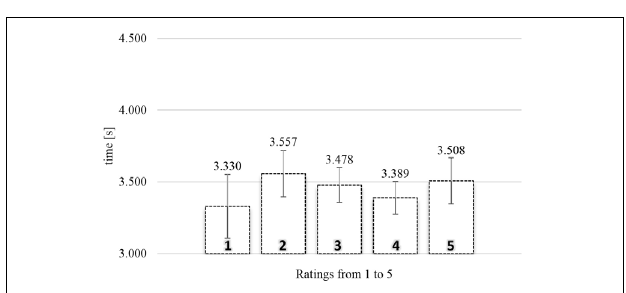
FIGURE 6 | Average exposure time of rejected (NO) and included (YES) naturalistic food images in the self-paced exclusive evaluation ( N = 78). Error bars reflect the 95% confidence interval around the